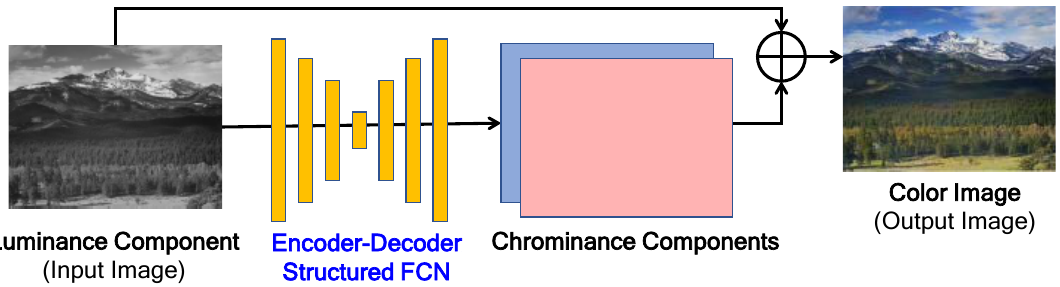
Figure 1. Typical network architecture for gray-to-color image